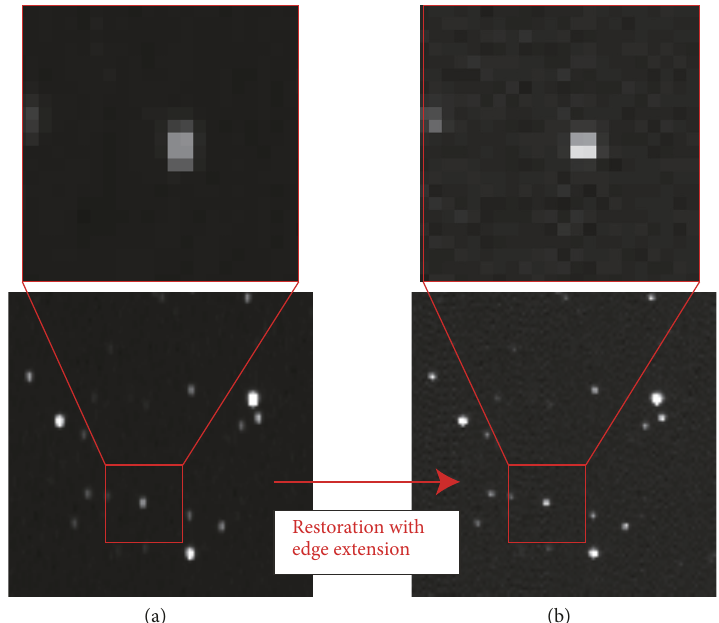
Figure 7: Experimental results when zenith angle is 45 ∘ . (a) The original image stars. (b) The corrected image stars.